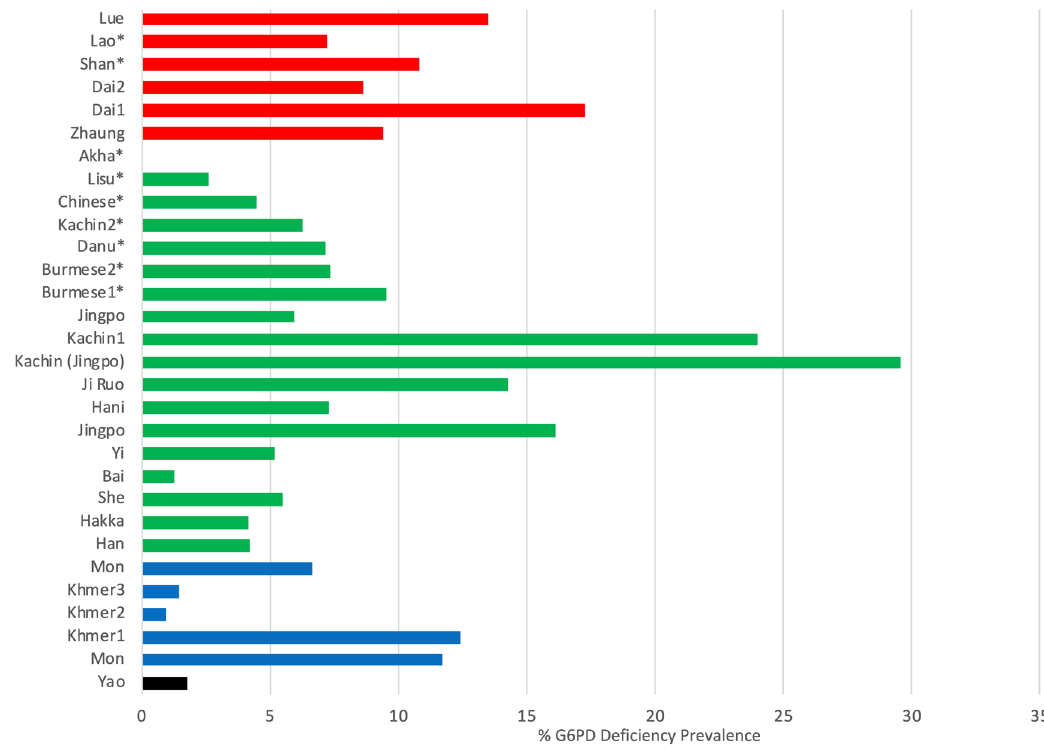
Figure 2. Prevalence of G6PD deficiency among ethnic groups residing in the upper Greater Mekong Subregion. Each ethnic group was classified by their spoken language as Tai-Kadai (red), Sino-Tibetan (green), Austroasiatic (blue), and Hmong-Mien (black) linguistic families. (*data obtained from males